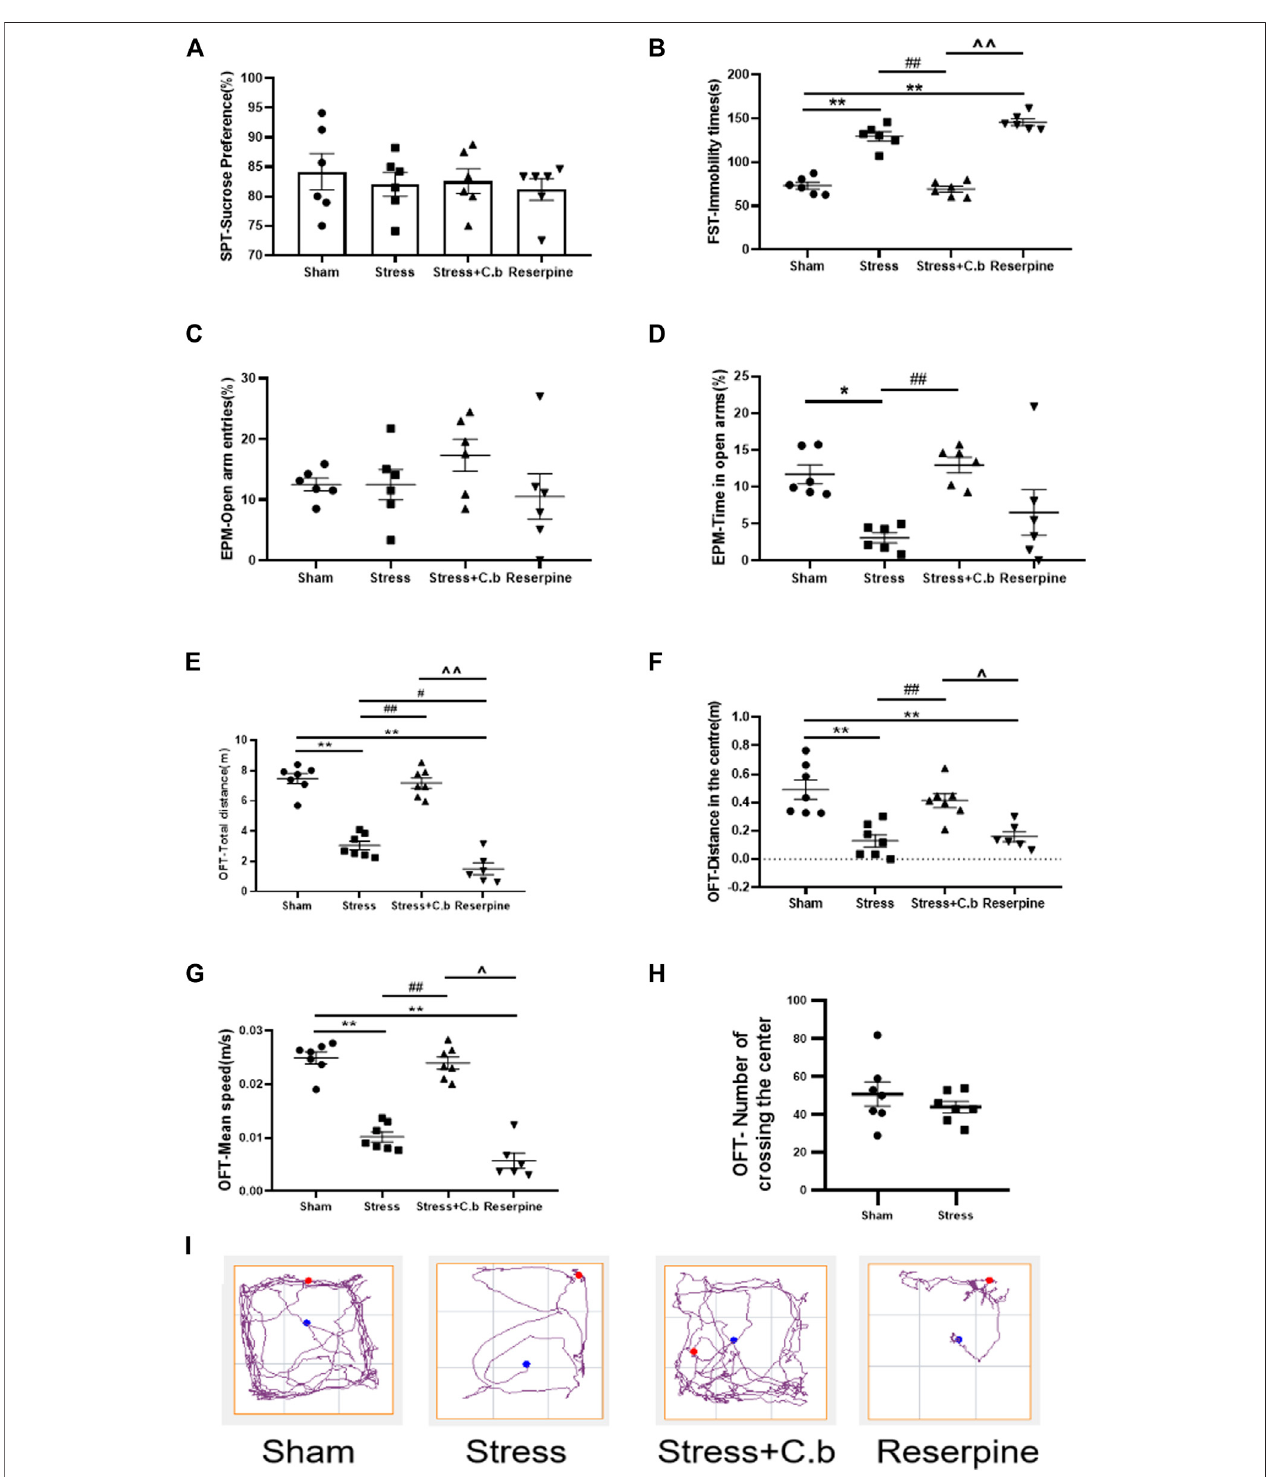
FIGURE 2 | C. butyricum RH2 treatment improved chronic foot shock stress (CFSS)-induced behavioral de fi cits in rats. (A) CFSS treatment did not induce a decrease in the sucrose consumption. (B) C. butyricum RH2 improved the increased immobility time induced by CFSS. (C) CFSS treatment did not change open arm entries. (D) C. butyricum RH2prolonged CFSS-induced decrease intime spent inthe open arm time. (E – G) C. butyricum RH2lengthened the central area distance, the total distance and the average speed in CFSS rats. (H) The number of crossing the center area in the OFT was not signi fi cantly different between CFSS rats and controlrats( p > 0.05). (I) TypicaltrackinOFT.Thedataareexpressed asmean±SEM(n=7insham,stress,stress+C.butyricumgroup;n=6inreserpinegroup).* p < 0.05, ** p < 0.01 versus sham group; # p < 0.05, ## p < 0.01 versus stress group; ^ p < 0.05, ^^ p < 0.01 versus stress + C. butyricum group.